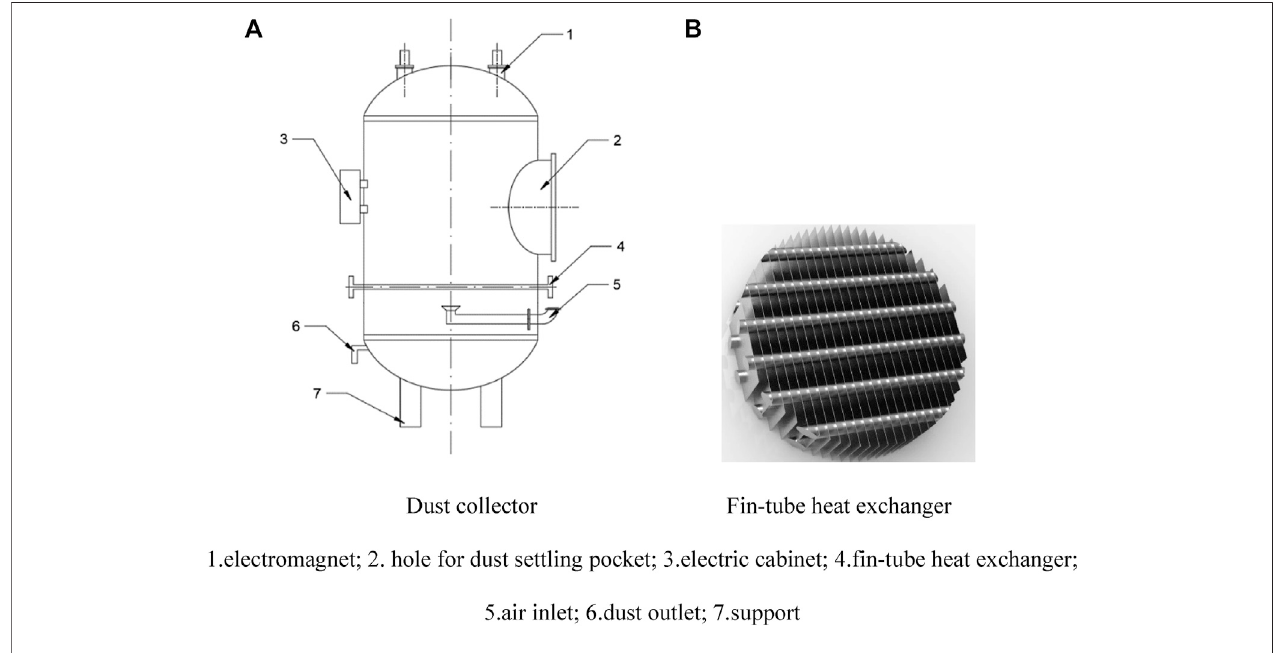
FIGURE 2 | Structure of the dust collector and its components.